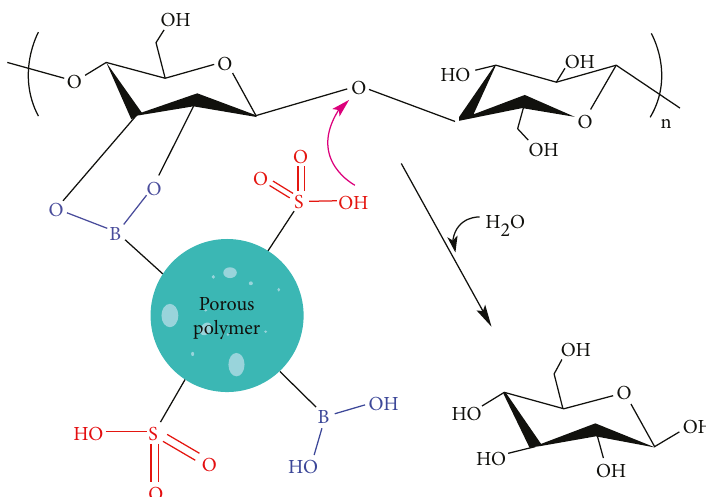
Scheme 4: Proposed hydrolysis mechanism of cellulose to glucose by a bifunctional porous polymer solid acid catalyst bearing boronic and sulfonic acids. Adapted from (Table 2, entry 2) [216]. This is because 40% IL/CMVB pro- moted a synergistic e ff ect for the hydrolysis of cellulose into glucose. The chlorine groups ( – Cl) in CMVB promoted the dissolution of cellulose by breaking intermolecular and intra- molecular hydrogen bonding, while the sulfonic acid groups ( – SO H) in IL promoted the dissociation of β -1,4-glycosidic 3 bonds to generate glucose units.